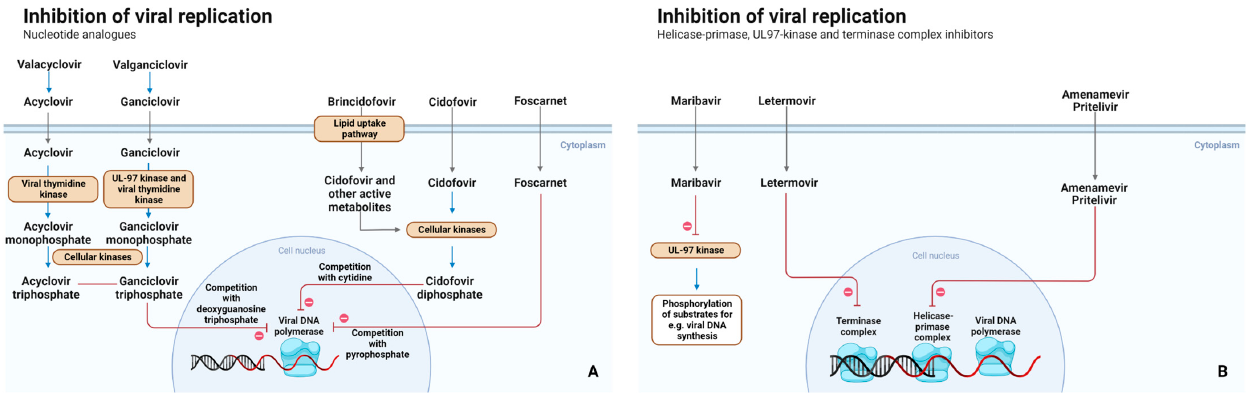
Figure 1. Mechanism of action of nucleotide analogs ( A ), helicase-primase, UL97-primase and terminase complex inhibitors ( B ). terminase complex inhibitors ( B